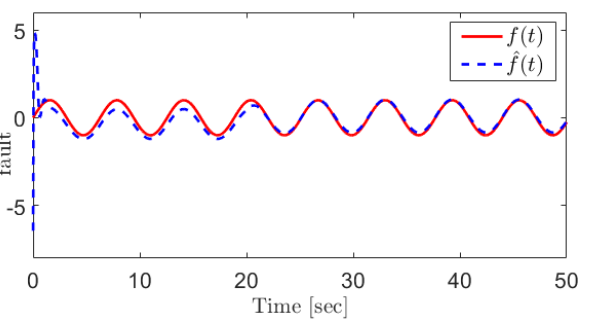
Figure 3. The manifold gas pressure sensor fault and its reconstruction using the proposed SOSMO method.